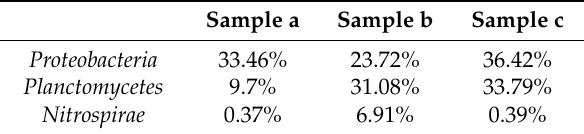
Table 5. The percentages of Proteobacteria , Planctomycetes , and Nitrospirae in seed sludge (a), domesticated sludge of the ASBR reactor (b), and domesticated sludge of the biofilter (c).